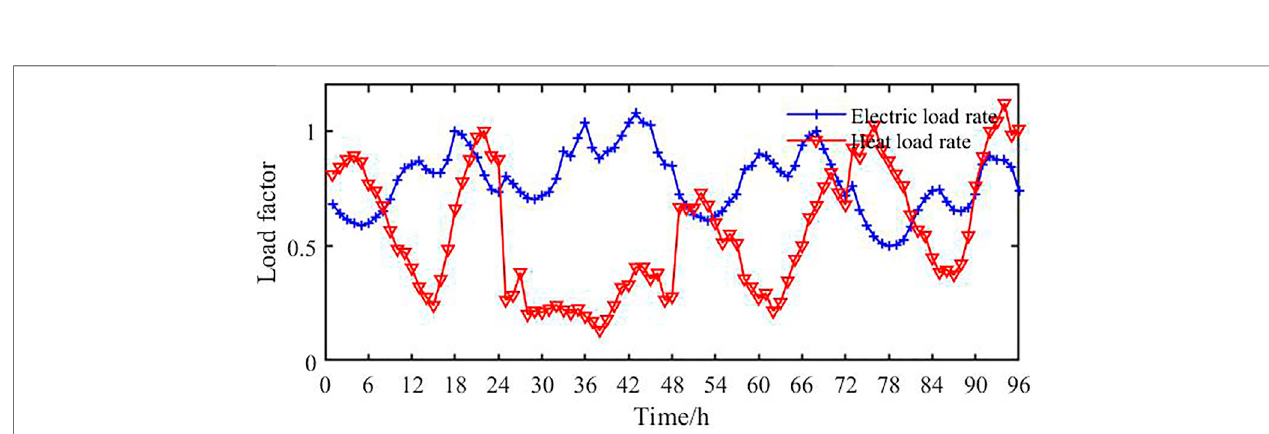
FIGURE 4 | Forecast values of electric and heat load rate during typical days of four